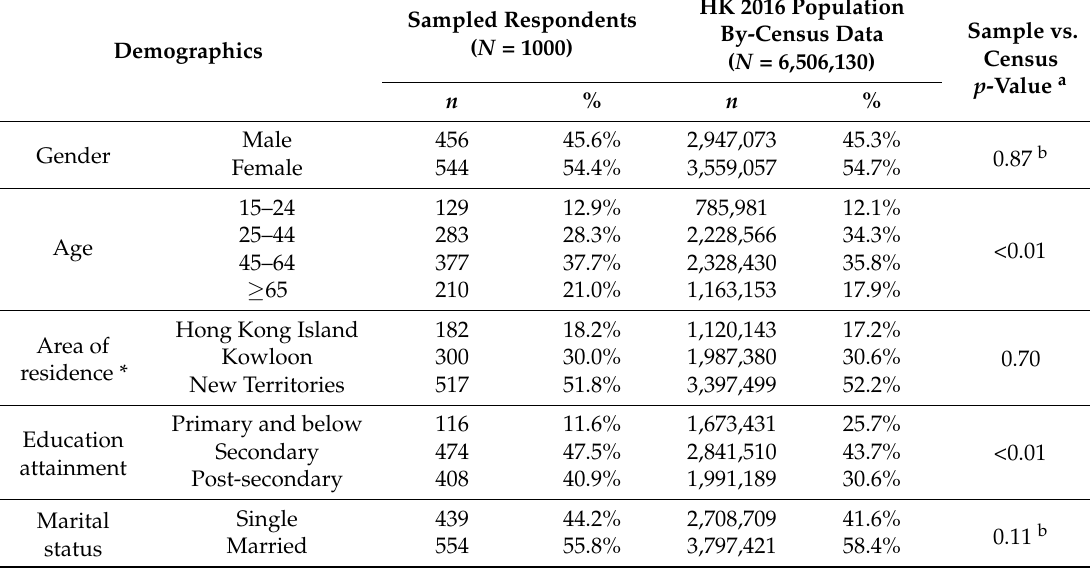
Figure 1. Study flow of the telephone survey. Table 1. Sociodemographic characteristics of the survey respondents in March 2017 and the general population in Hong Kong in 2016.